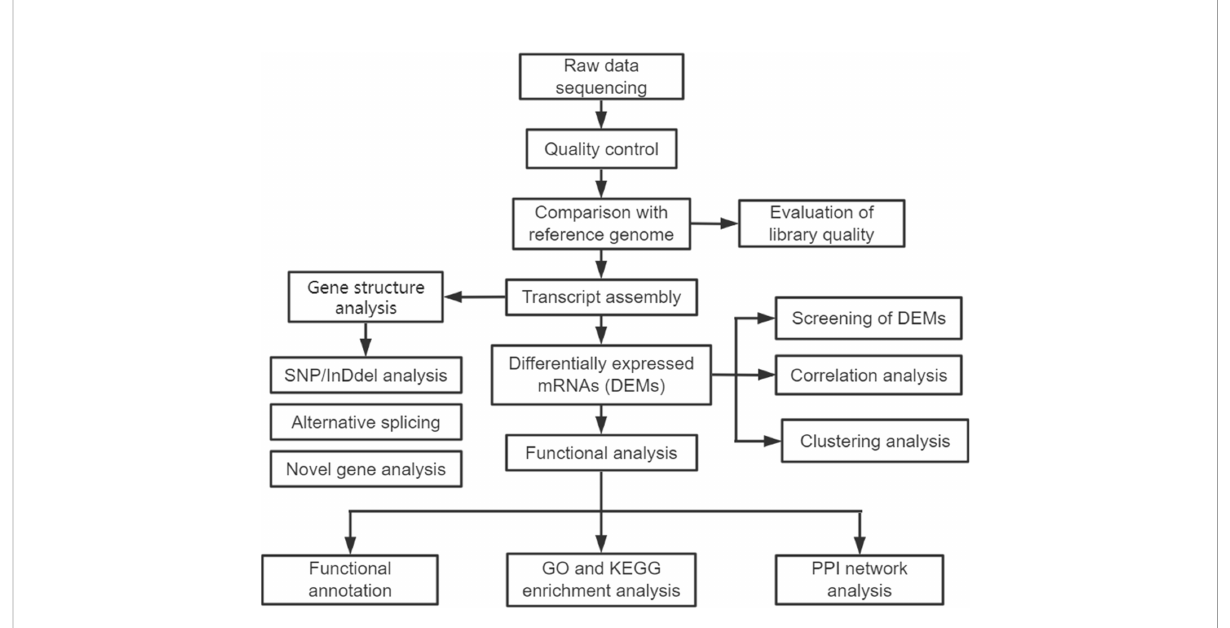
FIGURE 2 The analytical procedure for the sequencing data of exosomal